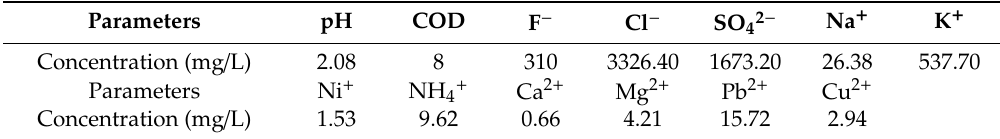
Table 1. The composition of actual F-containing smelting